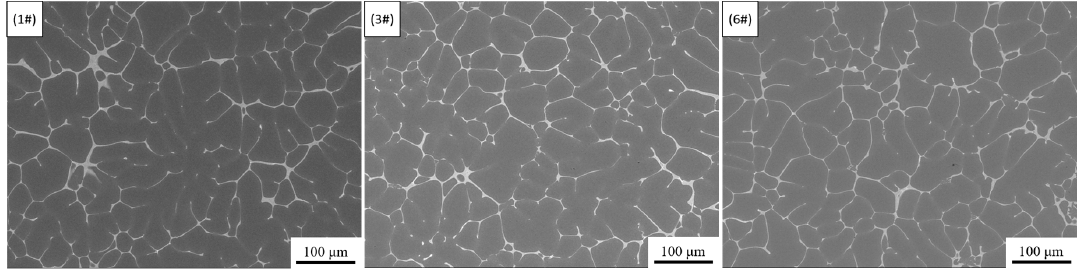
Figure 12. SEM backscattered photographs of 1#, 3# and 6# in as-cast status.